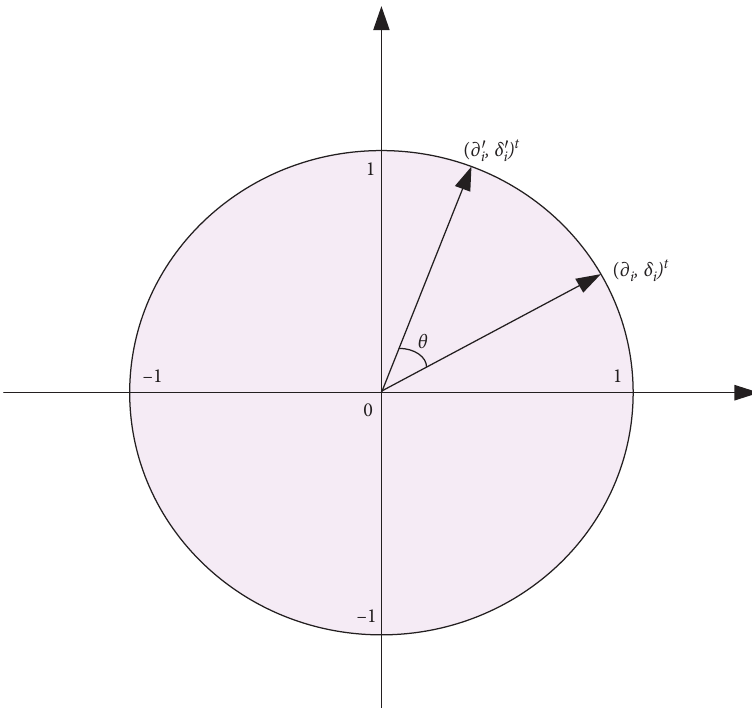
Figure 6: Schematic diagrams of the polar coordinates of the quantum rotating